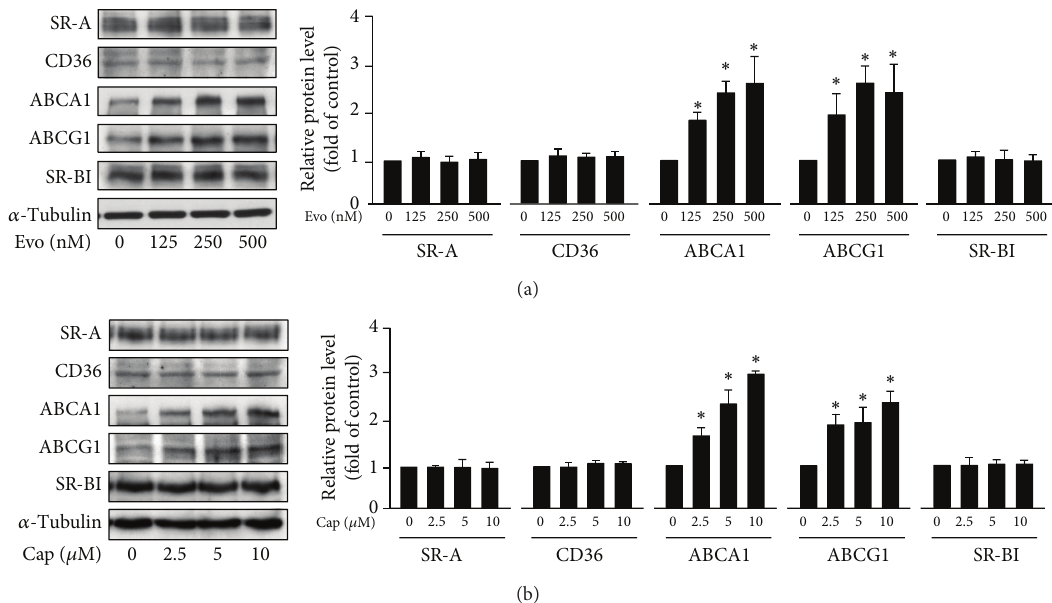
Figure 5: Effect of TRPV1 activation on expression of SR-A, CD36, SR-BI, ABCA1, and ABCG1 in macrophages. BMDMs were incubated with vehicle, (a) evodiamine (125, 250, 500 nM), or (b) capsaicin (2.5, 5, 10 𝜇 M) for 24h. Western blot analysis of protein levels of SR-A, CD36, ABCA1, ABCG1, SR-BI, and 𝛼 -tubulin. Data are mean ± SD from 5 independent experiments. ∗ 𝑃 < 0.05 versus vehicle-treated cells.